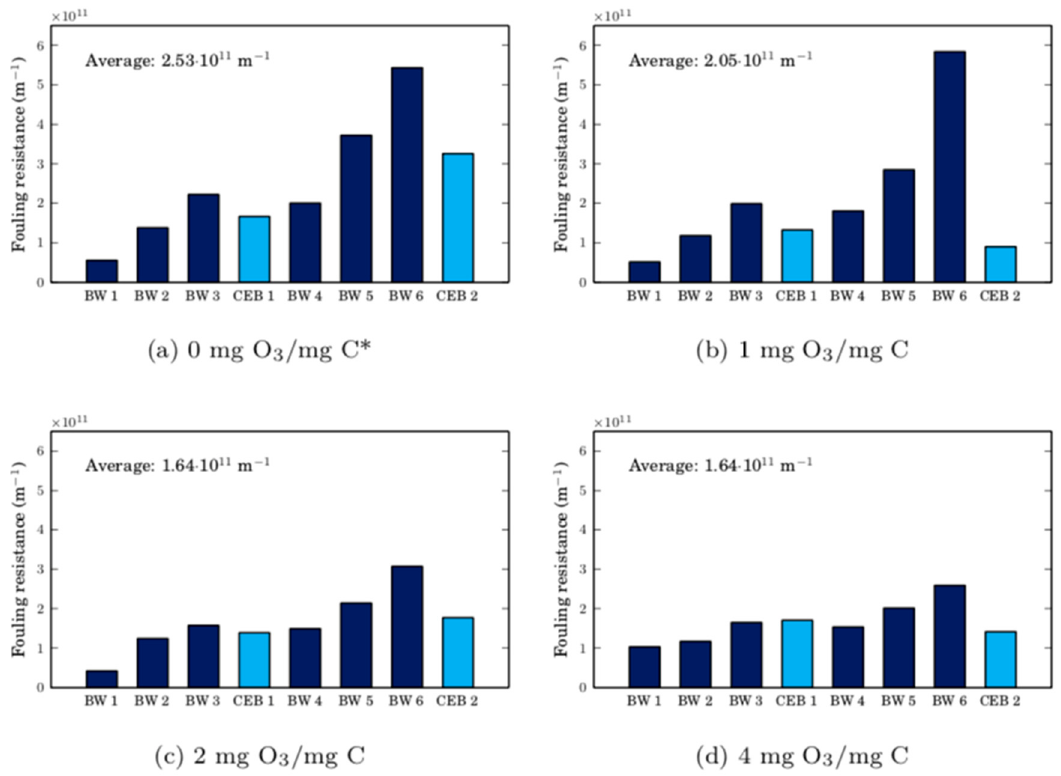
Figure 10. Membrane fouling resistances after hydraulic backwashes (BW) and ozone chemically enhanced backwashes (CEB) initiated during the filtration of Cyano-SW. The average fouling resistance of all cycles is provided as a metric to capture the effect of repeated CEB on long-term membrane performance. *In the baseline experiment (0 mg O 3 /mg C), the CEB was replaced with an extended hydraulic backwash.